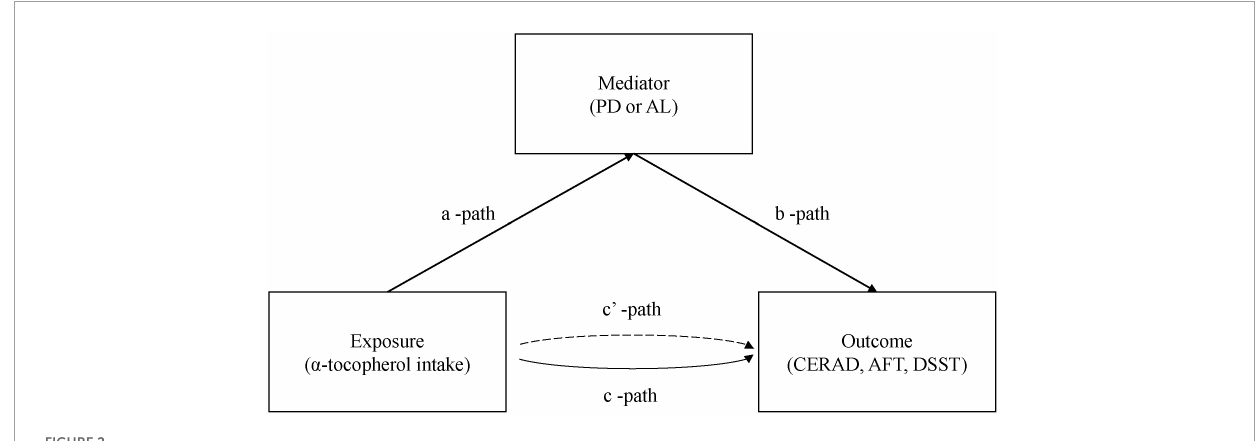
FIGURE2 Path diagram of the mediation analysis